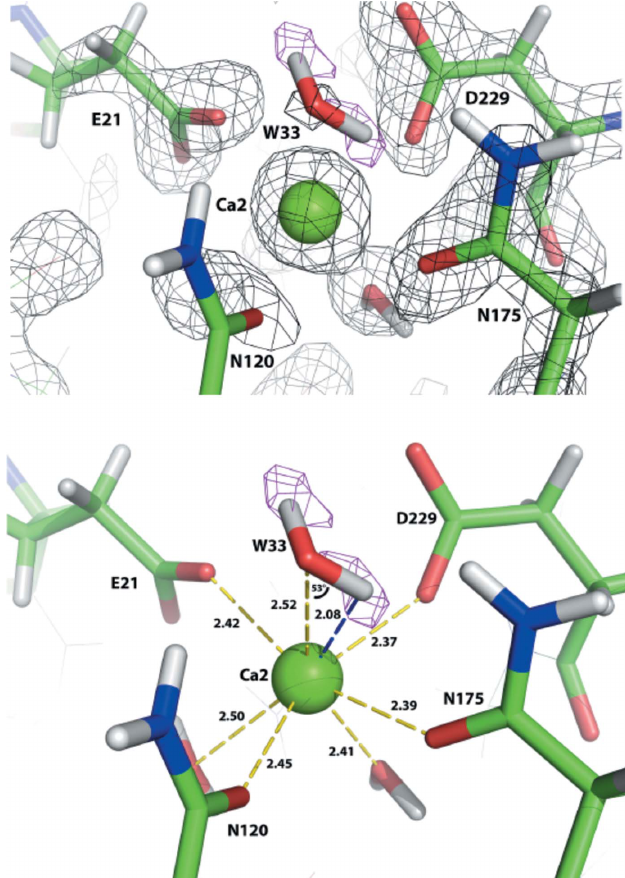
Figure 12 2 F o (cid:2) F c electron (gray) and nuclear F o (cid:2) F c OMIT (magenta) density maps of the DFPase active-site environment. W33 is clearly identified as a water molecule and not a hydroxide, and is situated in an orientation that maximizes hydrogen-bonding interactions. The Ca—O—D angle is 53 (cid:6) . Reprinted with permission from Blum et al. (2009), Proc. Natl Acad. Sci. USA , 106 , 713–718. Copyright (2009) National Academy of Sciences.